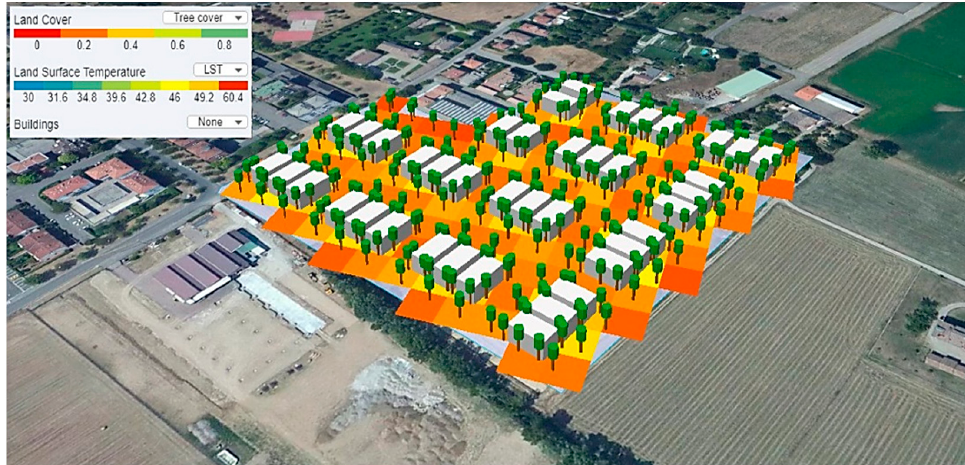
Figure 14. Hypotethical new urbanization generated by the model.